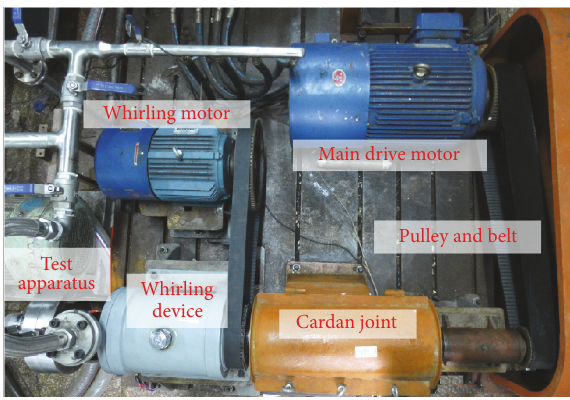
Figure 5: Global graph of the test rig.